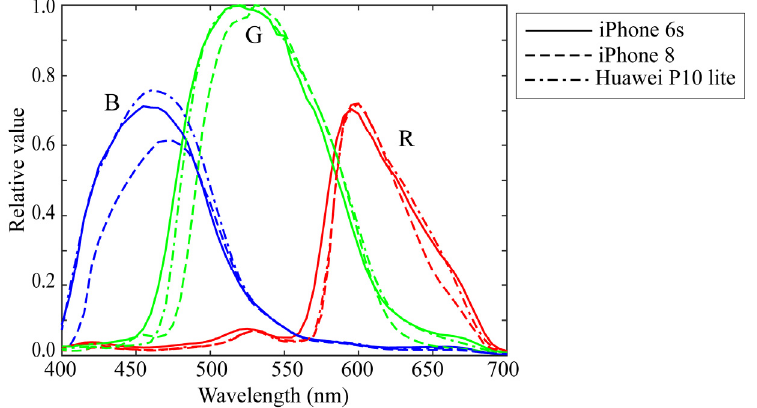
Figure 4. Relative RGB spectral sensitivity functions of three mobile phone cameras, where red, green, and blue curves correspond to Apple iPhone 6s, Apple iPhone 8, and Huawei P10 lite cameras, respectively.